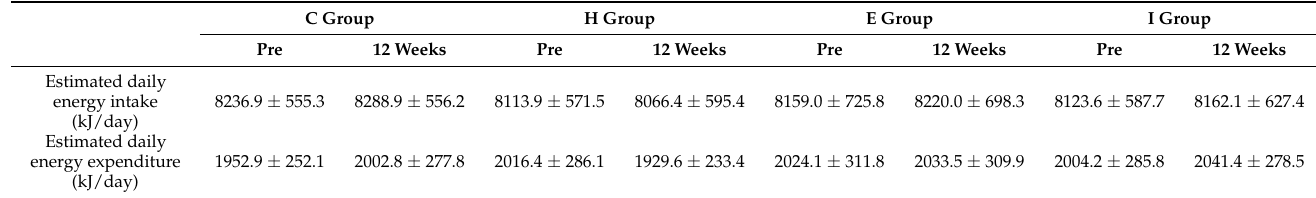
Table 2. Calorie expenditure and